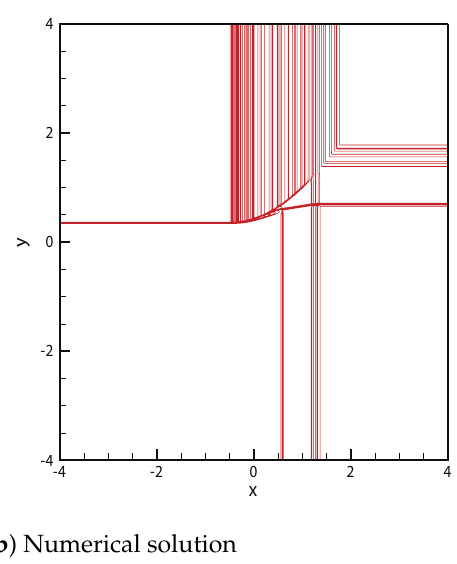
Figure 9. Case 9. R + S δ + JR + JR